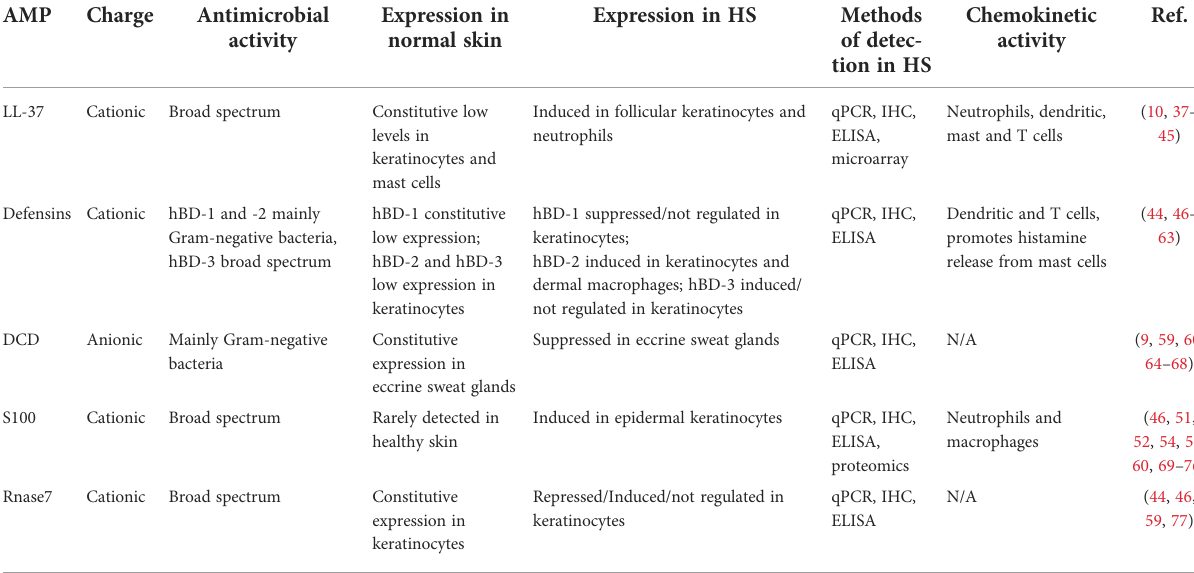
TABLE 1 Overview of major AMPs associated with HS